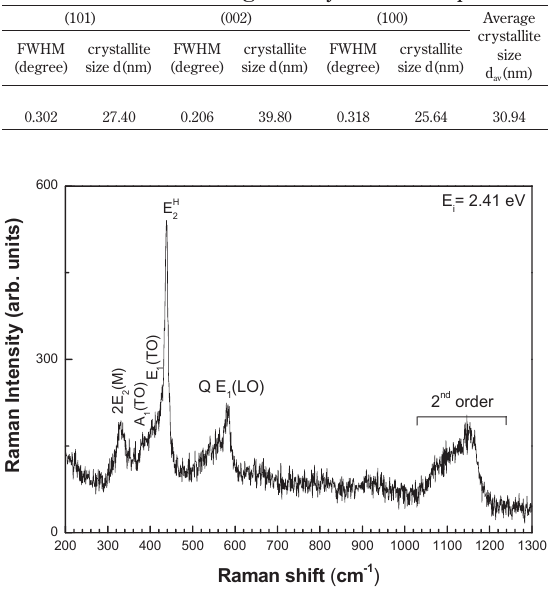
Table 1 The estimated average crystallite size from